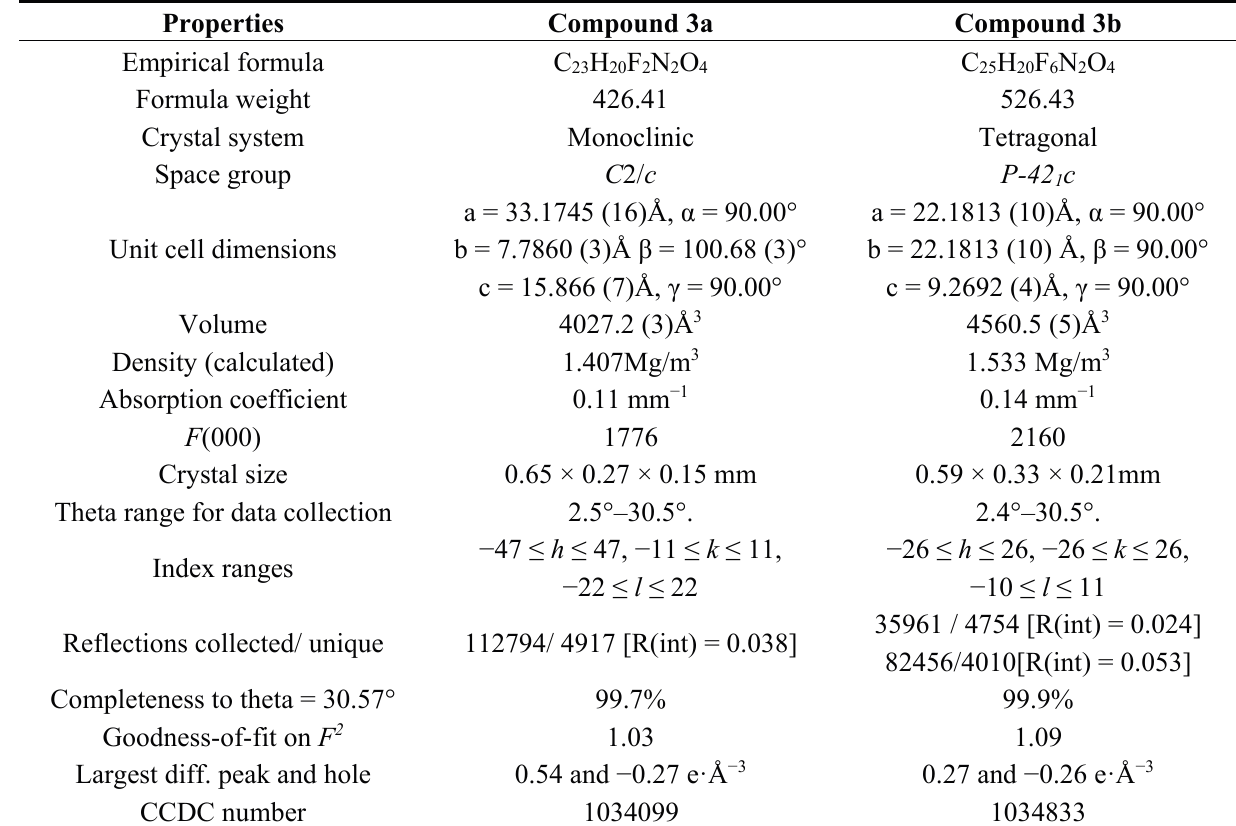
Table 2. The crystal and experimental data of compounds 3a and 3b